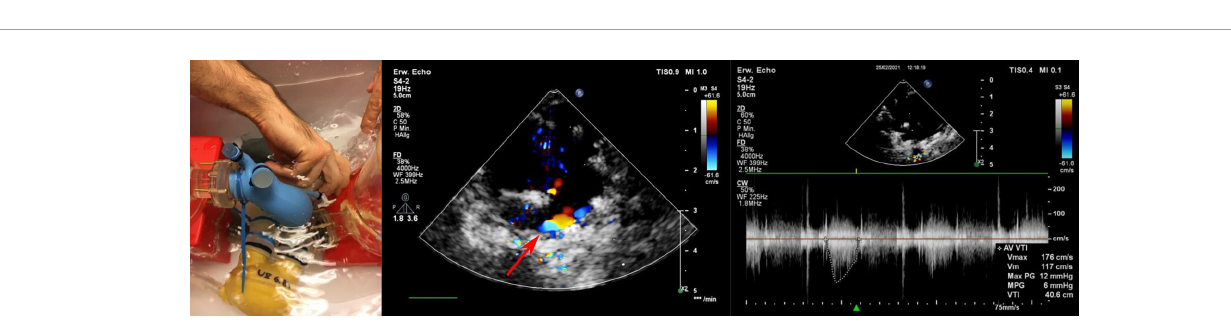
FIGURE10 Echocardiographic acquisition (left) and determination of PVLs by Doppler (middle) and continuous wave (right)